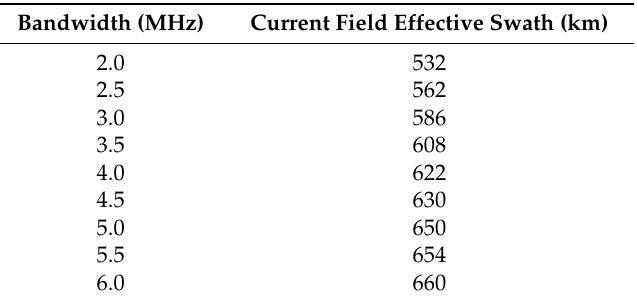
Figure 20. Surface current velocity components Std with bandwidths for a wind speed of 7 m/s and a wind direction of 90°: ( a ) along-track direction; ( b ) cross-track direction. Table 11. Current field effective swaths (current velocity Std of 0.05 m/s) with different bandwidths.